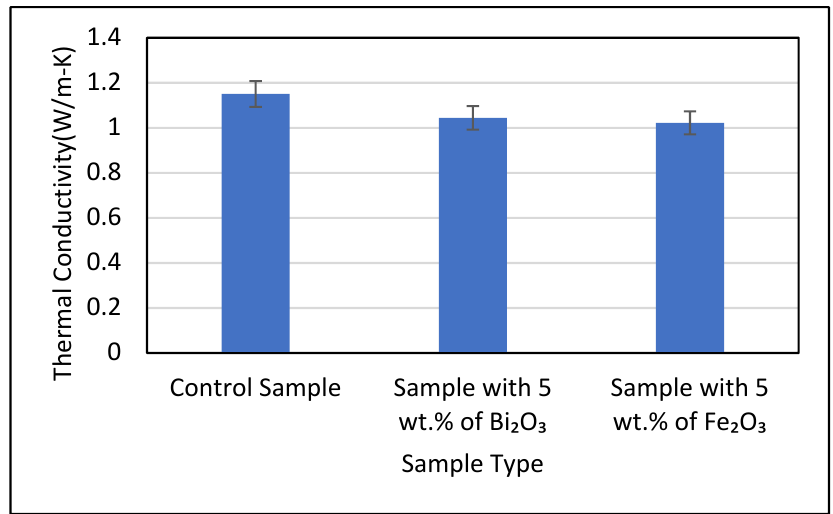
Figure 9. Thermal conductivity of control sample and cement composites with 5 wt.% Bi 2 O 3 and 5 wt.% Fe 2 O 3 at room temperature.